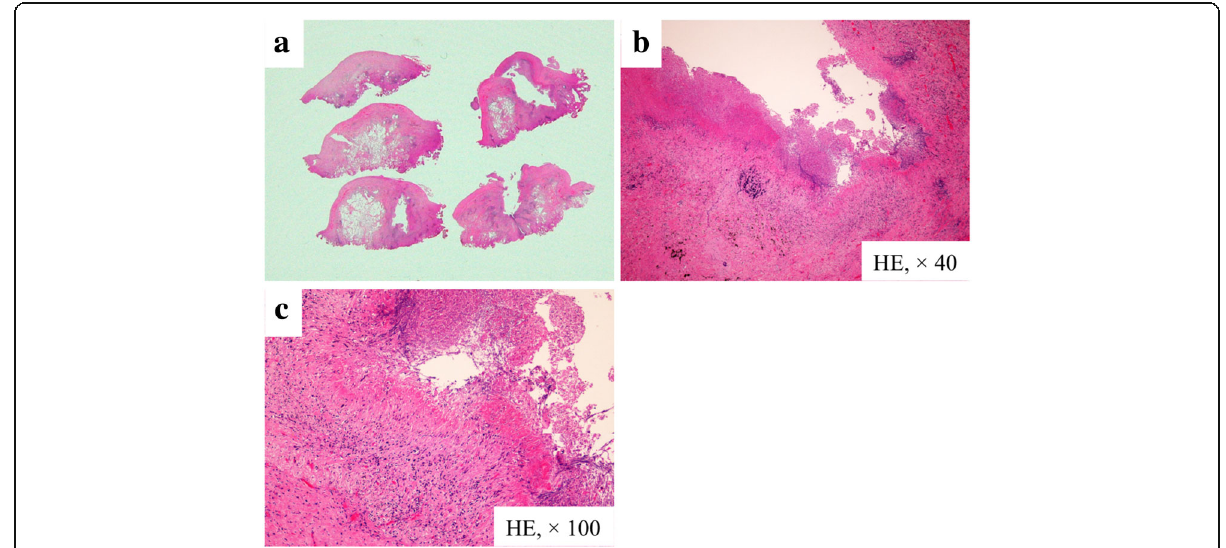
Fig. 5 Pathological diagnosis of the resected specimen. A subpleural rheumatoid nodule with cavitation and a defect in the pleura where the cavity had formed ( a loupe image). A highly magnified view of the lesion showing fibrinoid necrosis surrounded by histiocytes and lymphocytes ( b HE, × 40; c HE, ×